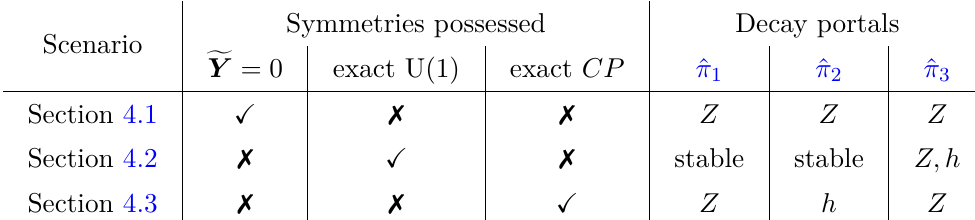
√ = (ˆ π ˆ π ) / 2 is stable because it is the lightest ± 1 ∓ i 2